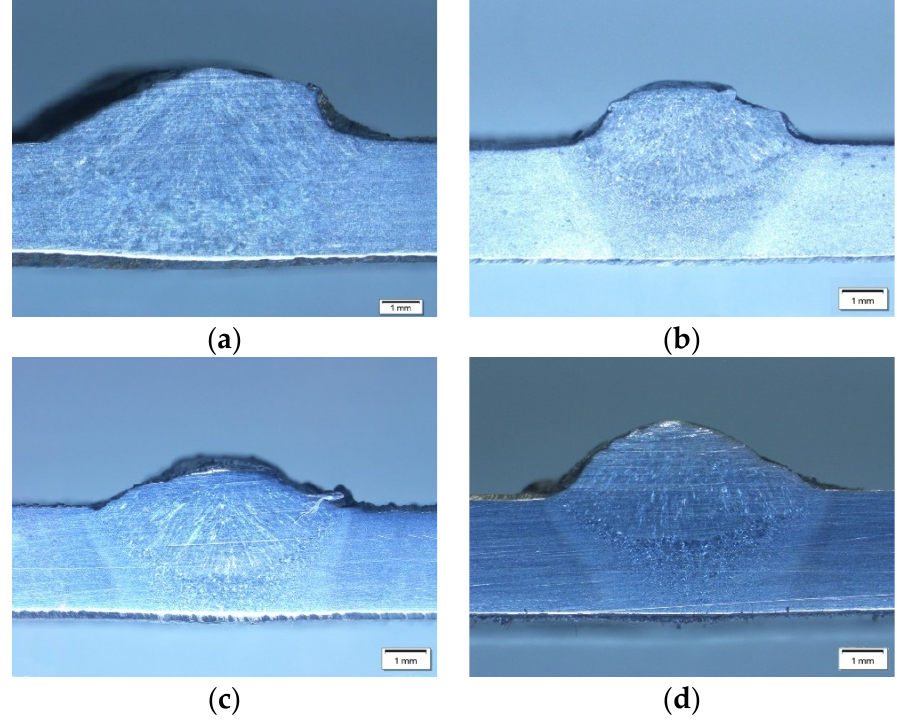
Figure 15. Macro-photograph of a welded specimen in ( a ) land-based welding, ( b ) underwater welding without flow, ( c ) underwater welding with the non-uniform flow with a baffle plate, and ( d ) underwater welding with the non-uniform flow without a baffle plate (scale 1 mm).